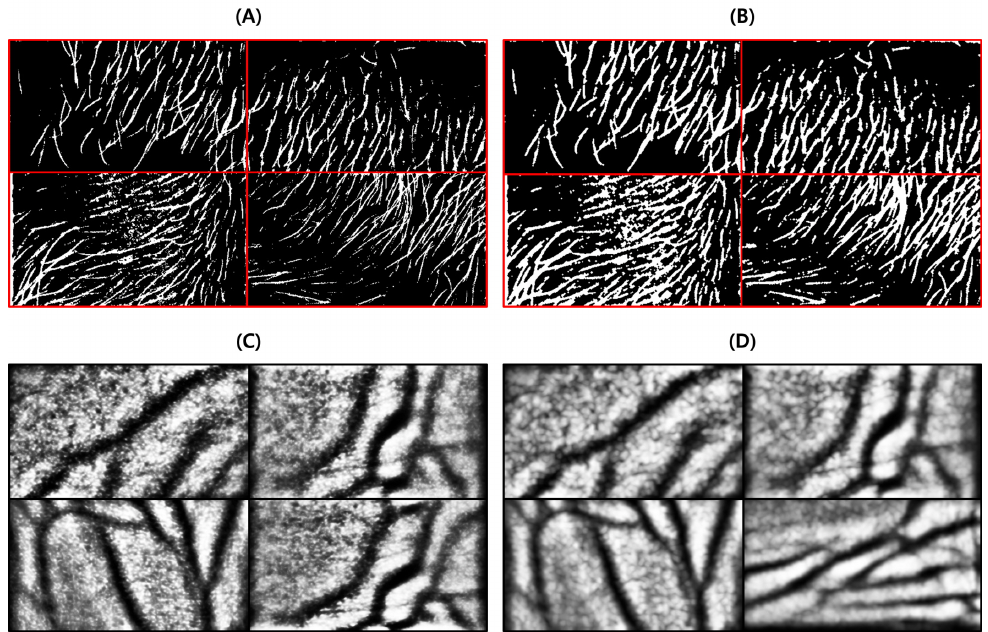
Figure 2. Results of applying morphological operations to the outline: ( A ) is the result of extracting body hair position (Blackhat), ( B ) is the result of removing noise and amplifying body hair by applying binary morphology dilate and open, and ( C ) is an image after histogram smoothing, ( D ) is an image obtained by applying an average filter and grayscale morphology operation to remove noise and perform operations for vein